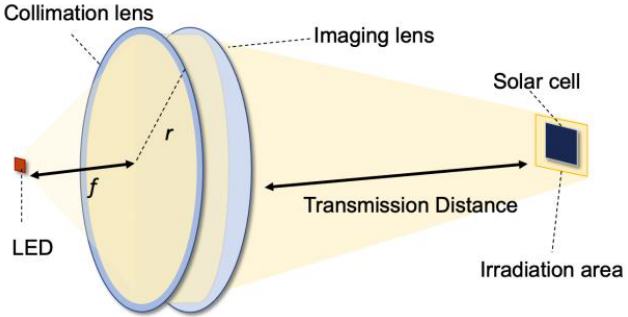
Figure 1. Collimation scheme in a single LED OWPT system .